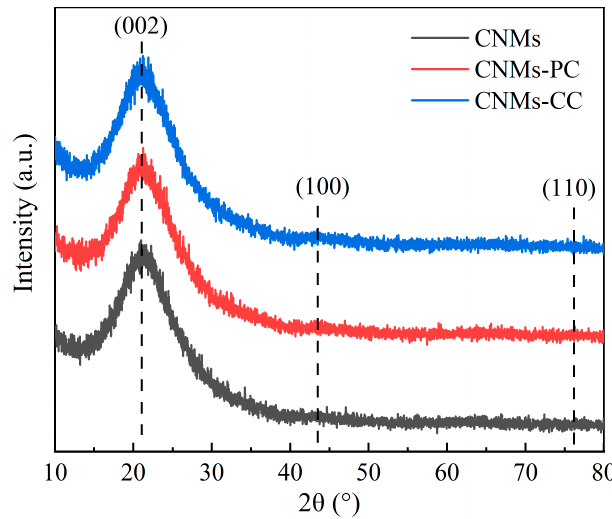
Figure 5. X-ray diffraction patterns of CNMs, CNMs-PC and CNMs-CC.